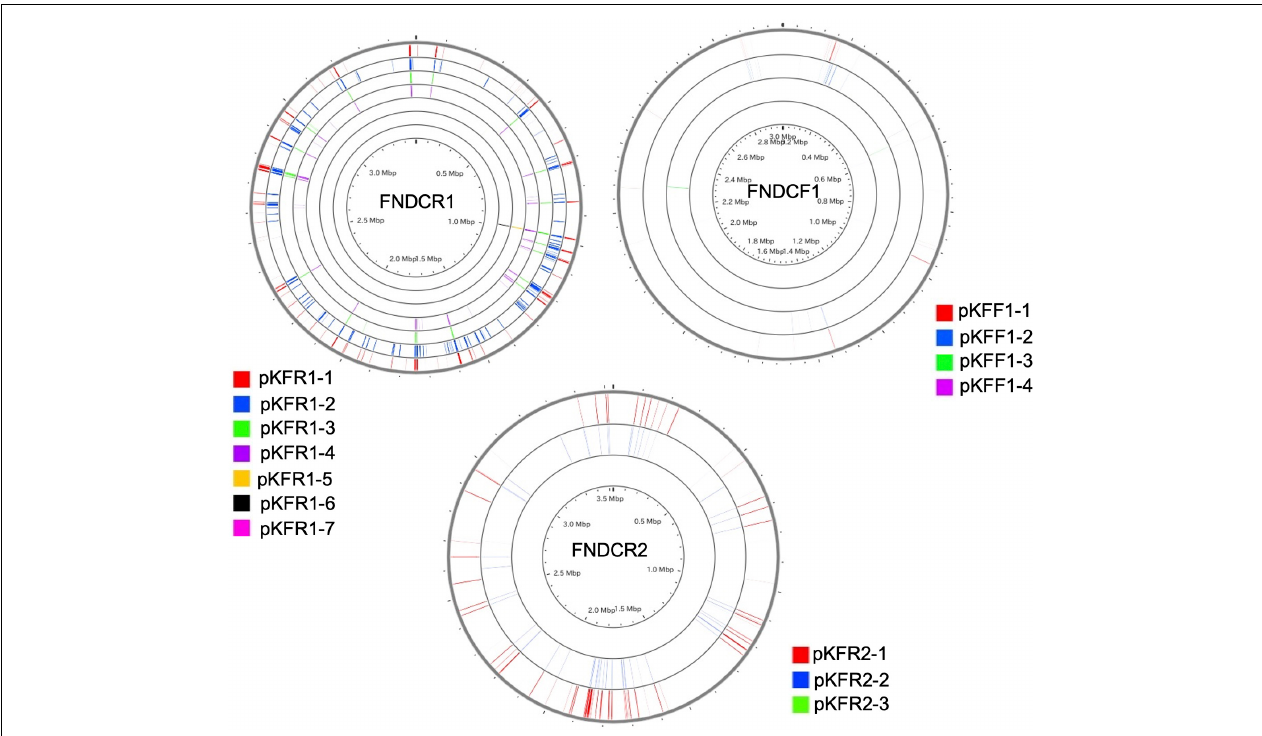
FIGURE 7 | Sequences shared with the chromosome and the plasmids. Homology search (blast algorithm) between each chromosome and plasmids in each strain (other circles) was performed on the CGview server beta. Each plasmid sequence was used as a query. Homologous sequences found on the chromosome are marked with colored